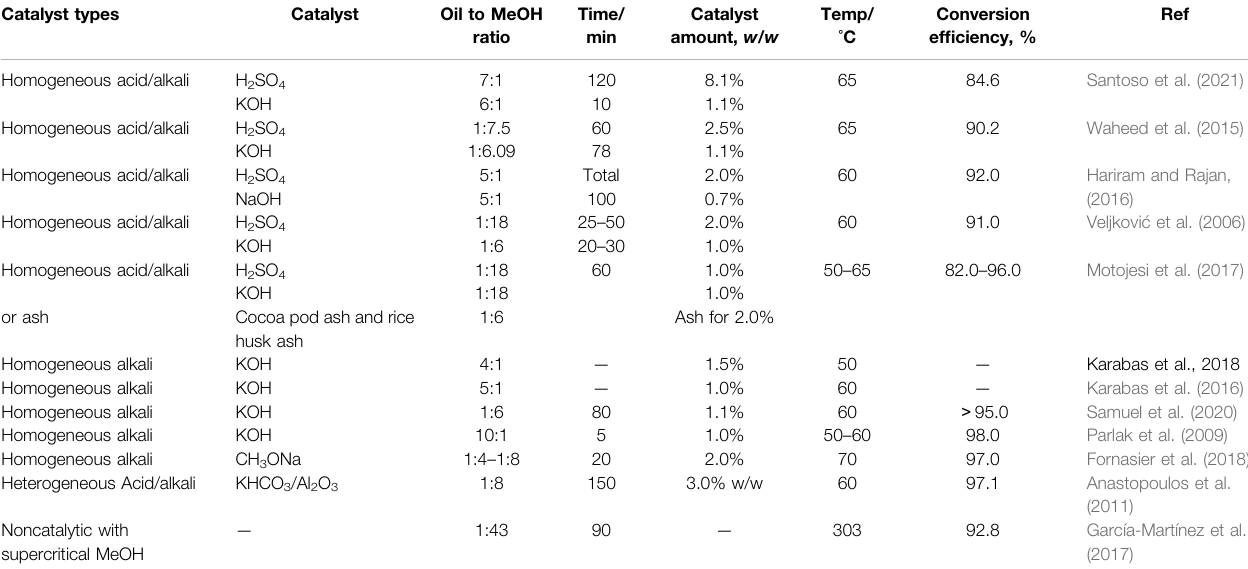
TABLE 2 | Catalysts for the transesteri fi cation of tobacco seed oil. Catalyst